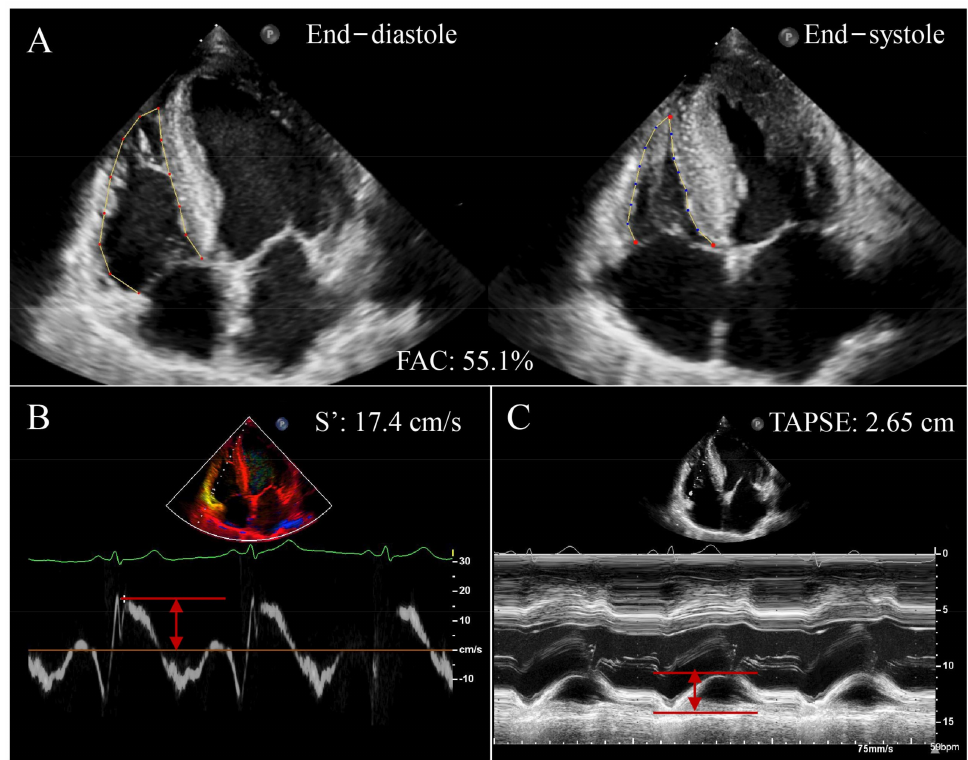
Figure 1. Conventional RV function parameters using two-dimensional echocardiography in a patient with HFrEF. ( A ) RVFAC; ( B ) S (cid:48) ; ( C ) TAPSE; RV, right ventricular; HFrEF, heart failure with reduced ejection fraction; RVFAC, right ventricular fractional area change; S (cid:48) , tricuspid annular systolic velocity;TAPSE, tricuspid annular plane systolic excursion. Red arrows represent measurements for